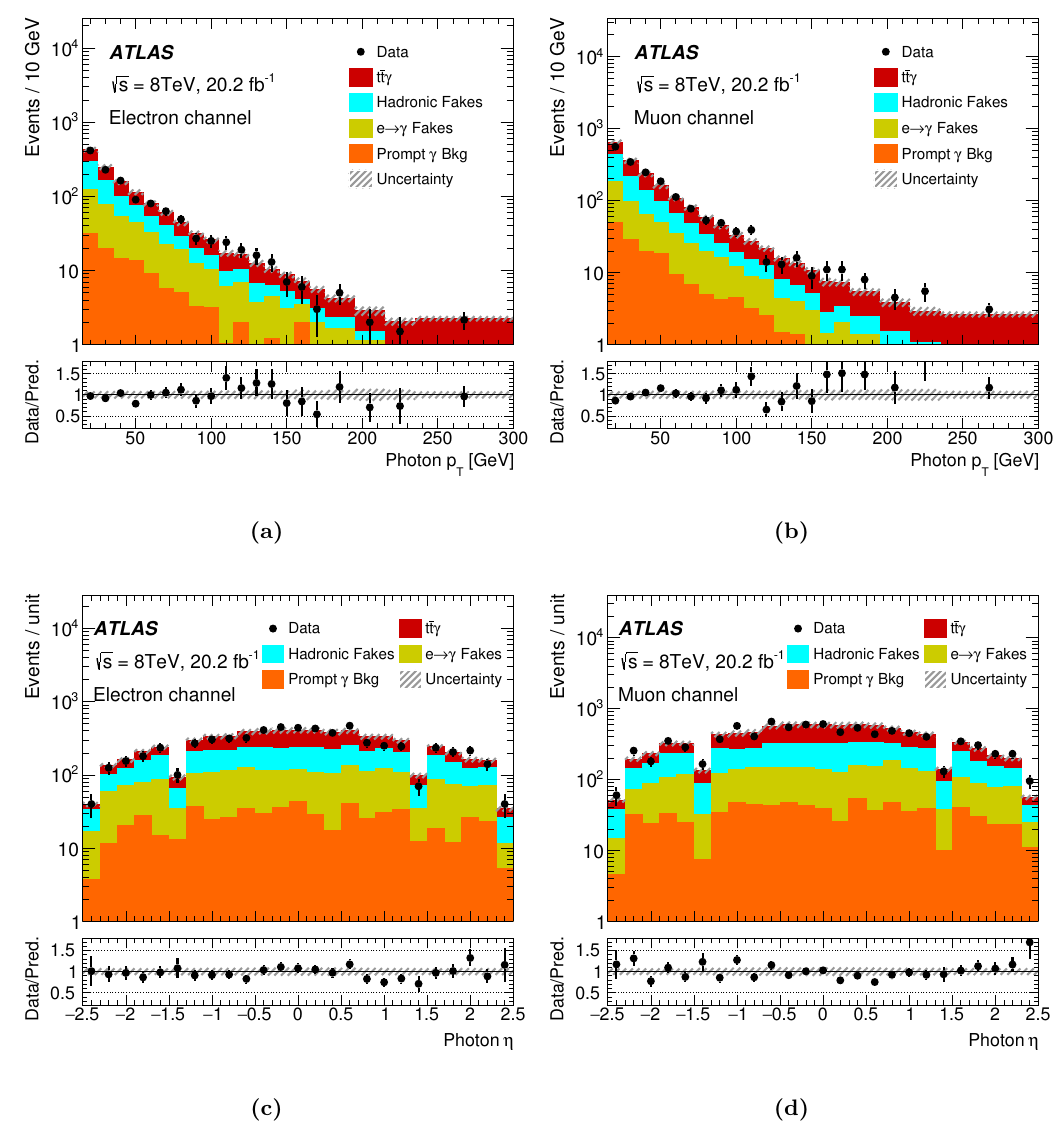
Figure 1. Comparison of data and the expected distributions in the events passing the t (cid:22) t(cid:13) selection for the (a), (c) single-electron channel and (b), (d) single-muon channel. The expected signal and background distributions include the prediction for signal ( t (cid:22) t(cid:13) ), normalised to the next-to-leading- order calculation [9], as well as for other processes with prompt photons, such as W(cid:13) +jets and Z(cid:13) +jets production from simulation (prompt (cid:13) bkg), where the W(cid:13) +jets contribution is scaled with a data-driven method. The contributions of events in which an electron is misidenti(cid:12)ed as a photon ( e ! (cid:13) fakes) and of events in which hadrons are misidenti(cid:12)ed as photons (hadronic fakes) are estimated from data. The shaded band corresponds to the total uncertainty of the expected signal and backgrounds. Panels (a) and (b) show the photon p T distributions, where the over(cid:13)ow is included in the last bin, while (c) and (d) show the (cid:17) distributions of the photons.